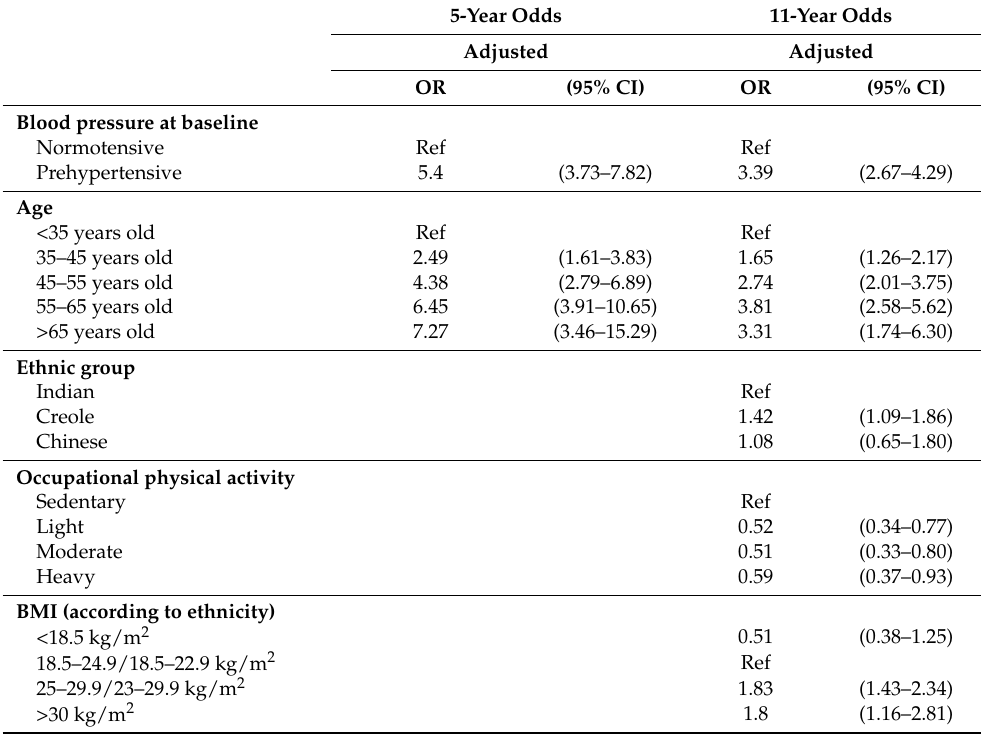
Table 4. Adjusted predictors of 5- and 11-year risk of hypertension in normotensive and prehypertensive people at baseline in Mauritius in